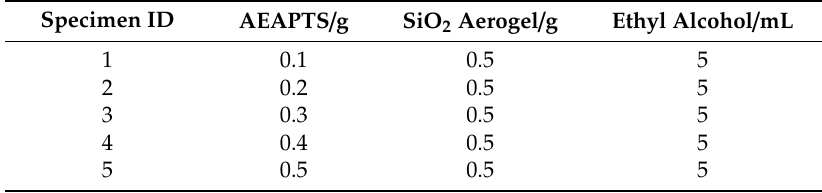
Table 1. Experimental design for superhydrophobic colloidal solutions.